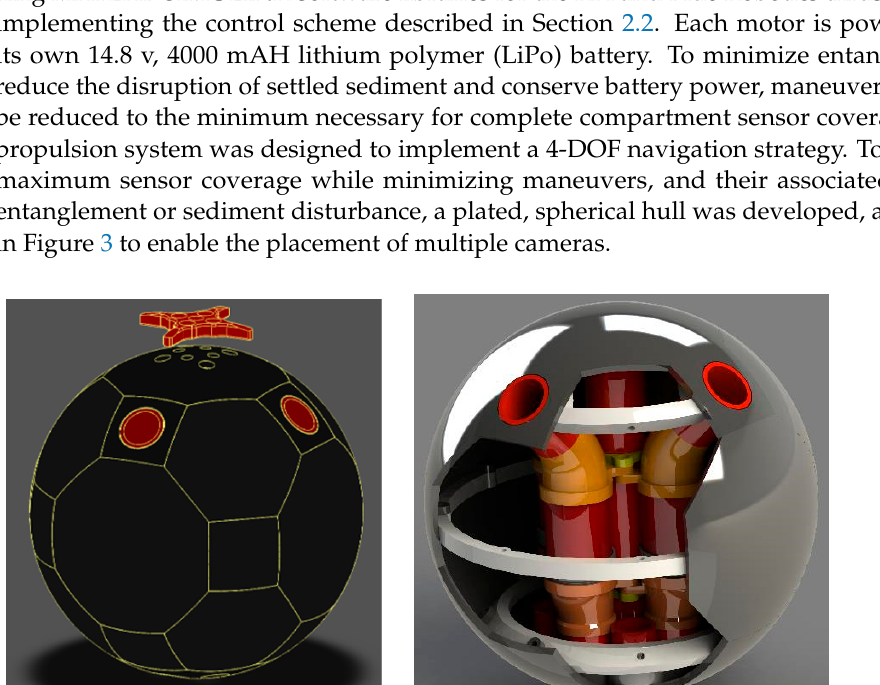
Figure 3. Renderings of WIEVLE’s spherical, plated hull ( a ) Exterior plated hull ( b ) Individual plates are connected via plate retention